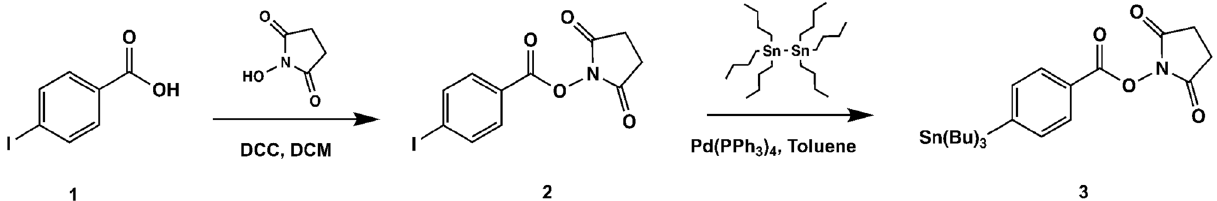
Figure 3. Synthesis of the stannyl precursor.